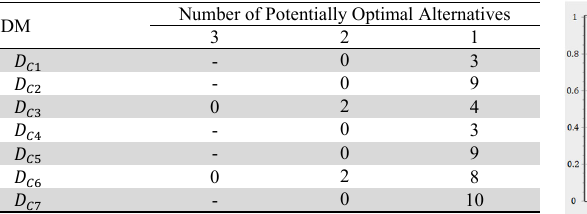
FITradeoff current results for case C